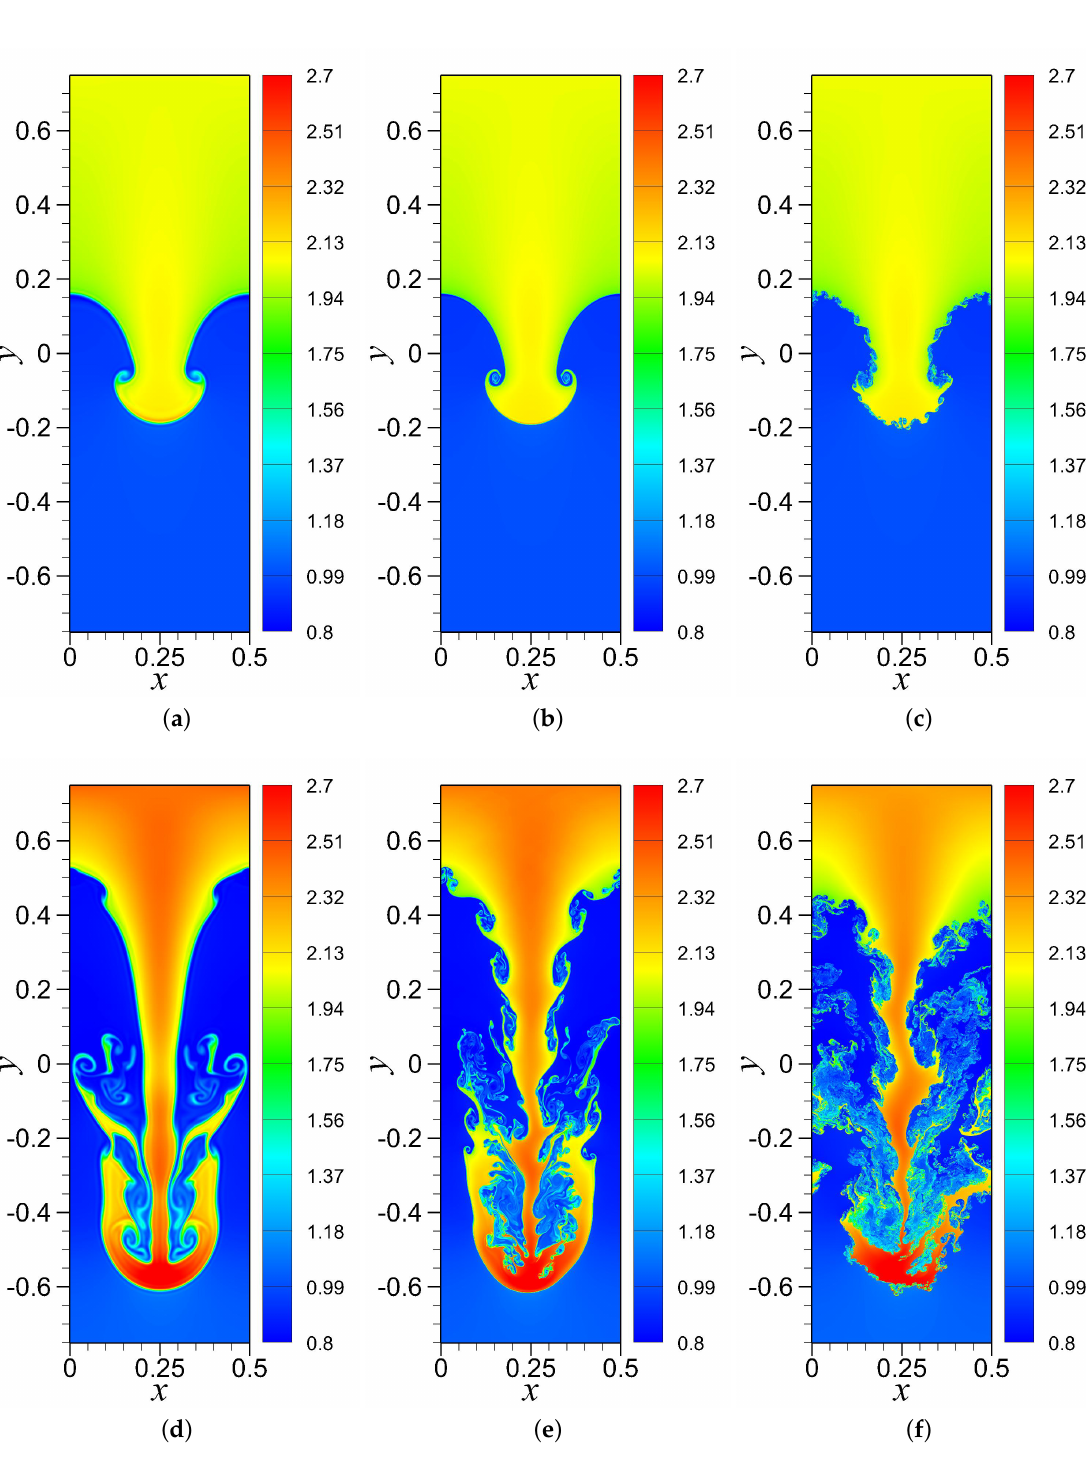
Figure 16. Time evolution of density field for the RTI problem with single-mode perturbation for different coarse grid resolutions using CS+RF scheme ( σ = 0.4): ( a ) CS+RF scheme ( σ = 0.4) with 256 × 768 resolution at t = 2.7; ( b ) CS+RF scheme ( σ = 0.4) with 1024 × 3072 resolution at t = 2.7; and ( c ) CS+RF scheme ( σ = 0.4) with 4096 × 12288 resolution at t = 2.7; ( d ) CS+RF scheme ( σ = 0.4) with 256 × 768 resolution at t = 4.5; ( e ) CS+RF scheme ( σ = 0.4) with 1024 × 3072 resolution at t = 4.5; and ( f ) CS+RF scheme ( σ = 0.4) with 4096 × 12288 resolution at t = 4.5. The gravity is directed in a vertically downward